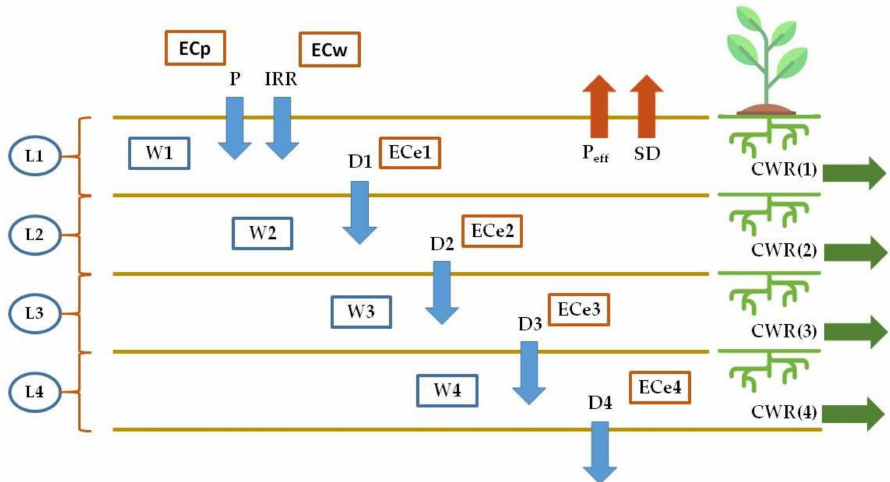
Figure 4. Schematic representation of the water and salt balance model used to simulate the long-term scenarios of soil salinity risk. Wi = water content in the ith soil layer (with i = 1, 2, 3, and 4, respectively); ECe i = electrical conductivity of the soil saturated water extract in the ith soil layer (with i = 1, 2, 3, and 4, respectively); CWR = crop water requirement; ECp = electrical conductivity of precipitation; ECw = electrical conductivity of irrigation water; P eff = effective precipitation; SD = soil